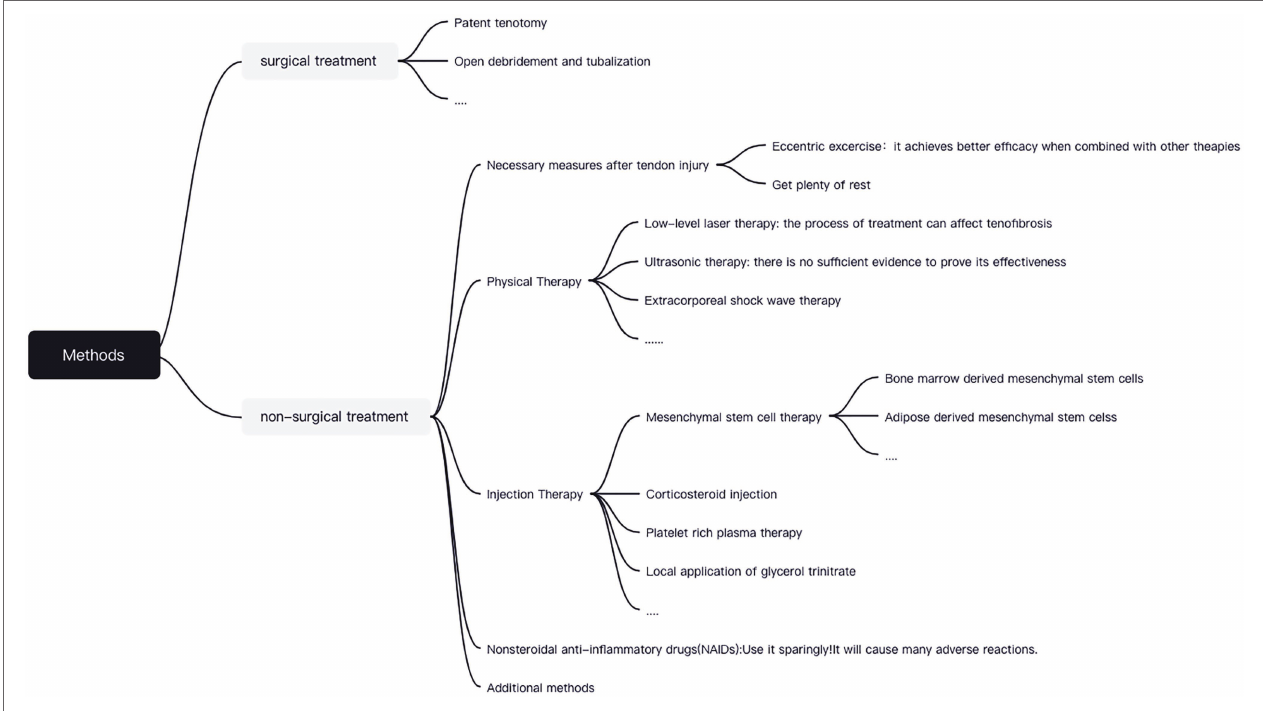
FIGURE 2 | Different treatments for tendon